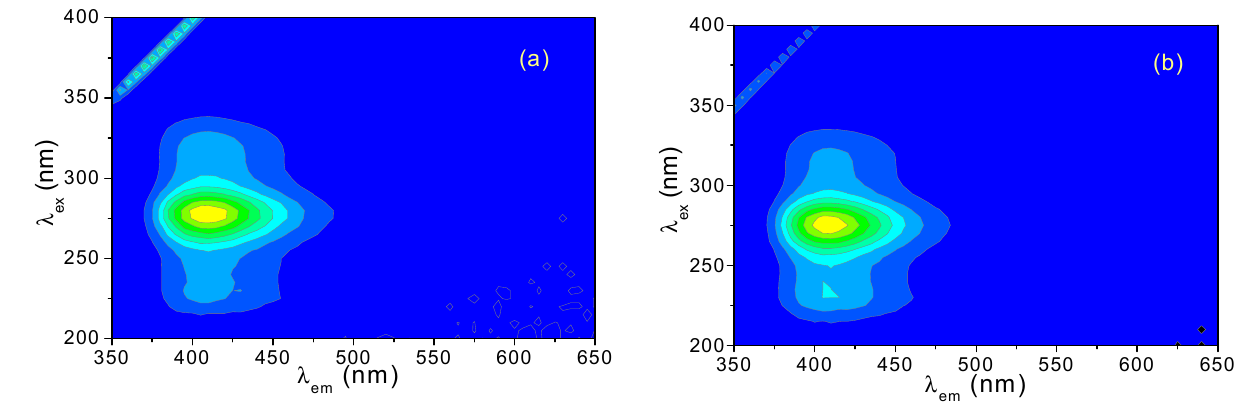
Figure 6. 3D fluorescence spectra of CH ( a ) and ECH ( b ) in alkaline solutions. c CH = 0.159 μ g·mL − 1 , c ECH = 0.146 μ g·mL − 1 , pH 11.9, MeOH 2.0%, contour interval: 500.